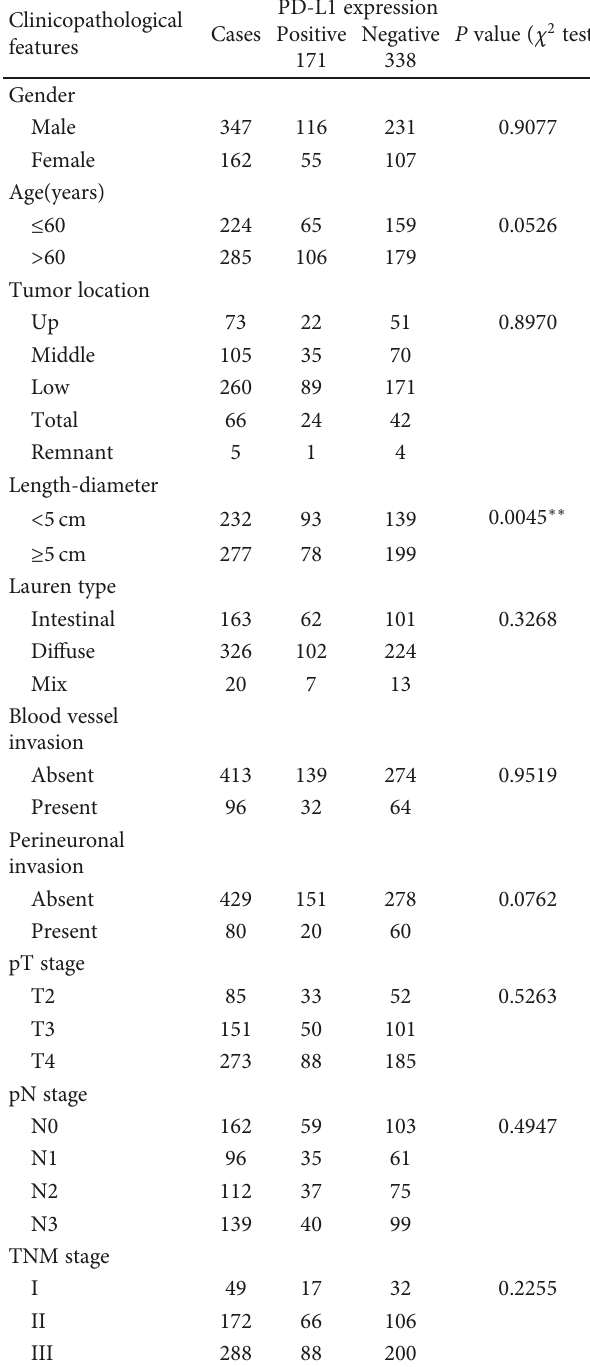
Table 1: Correlation between tumor PD-L1 expression and clinicopathological parameters in GC